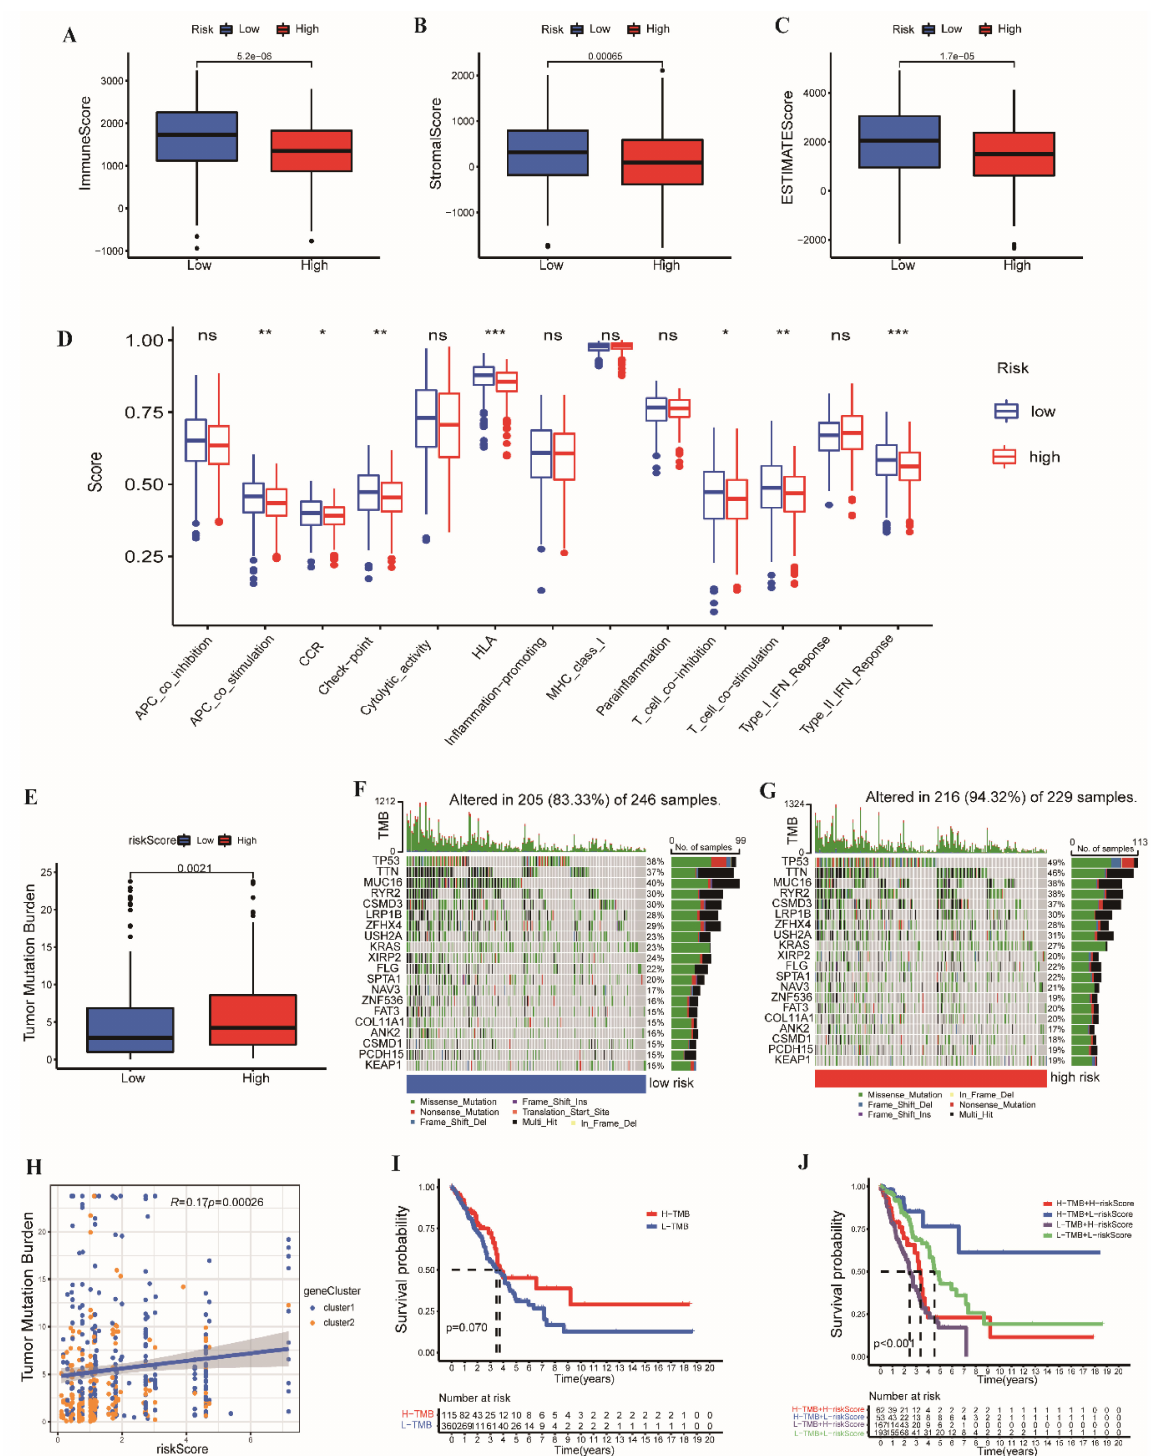
Figure 8. The distributions of the ( A ) immune score, ( B ) stromal score, and ( C ) ESTIMATE score of the low- and high-risk groups. ( D ) The proportion of the 13 immune-related pathways of the two groups. ( E ) The TMB boxplot of the two groups. ( F , G ) The waterfall plots of the top 20 most frequently mutated genes in low- and high-risk groups. ( H ) The correlation analysis between the TMB and risk score based on UbRGPs. Survival curves for patients grouped by ( I ) TMB alone ( p = 0.07), and ( J ) the combination of the risk score and TMB ( p < 0.001). (5.2e − 06 = 5.2 × 10 − 6 ; * p < 0.05; ** p < 0.01; *** p < 0.001; ns, p ≥